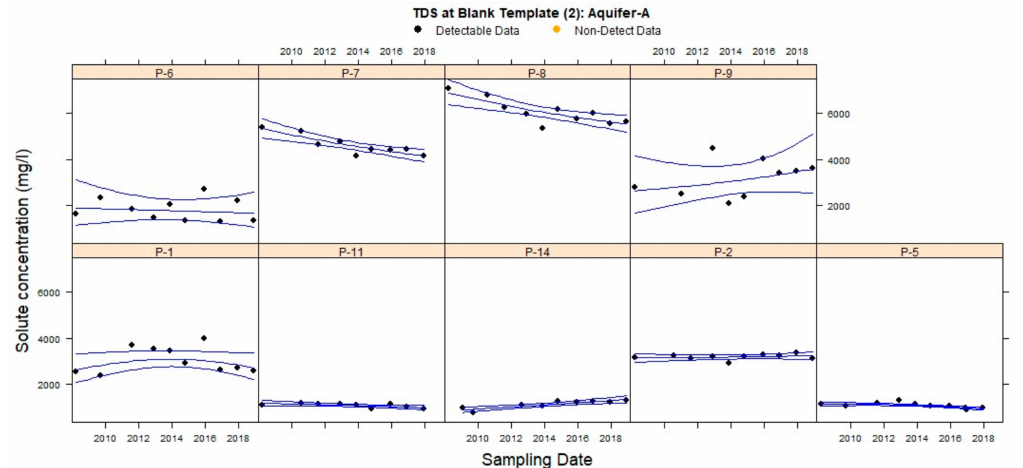
Figure 6. Total dissolved solid (TDS) variability in analyzed